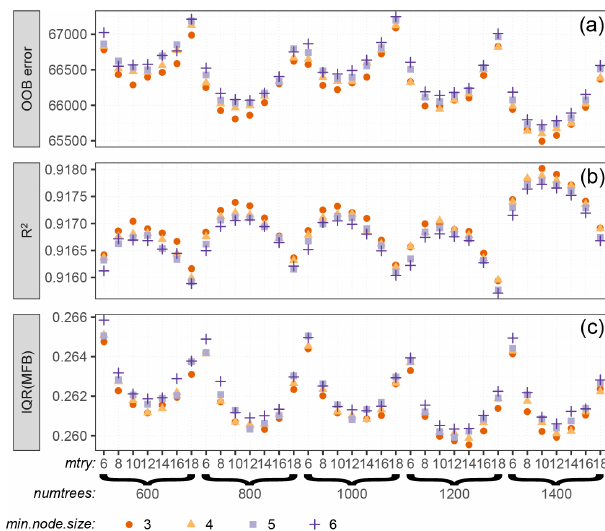
Figure 5. RFRM evaluation through OOB error (a) , R 2 (b) , and IQR(MFB) (c) with varying hyperparameters selected from the best balanced (accuracy and computational expense) ranges in Fig. 4.